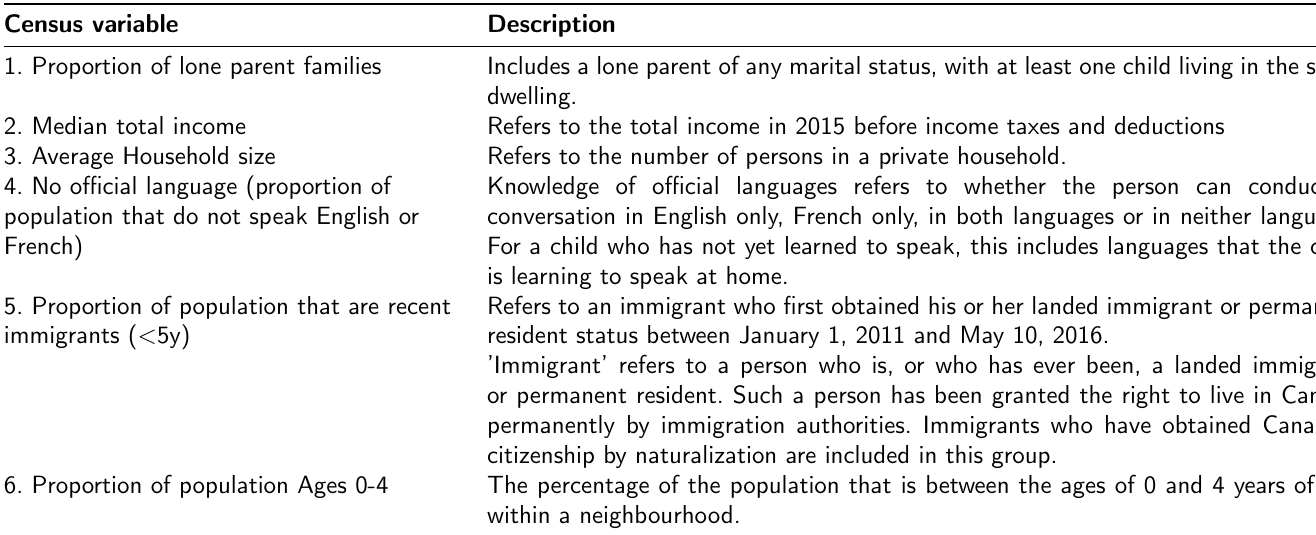
Table 3: List of Canadian census variables included in the study, along with their description